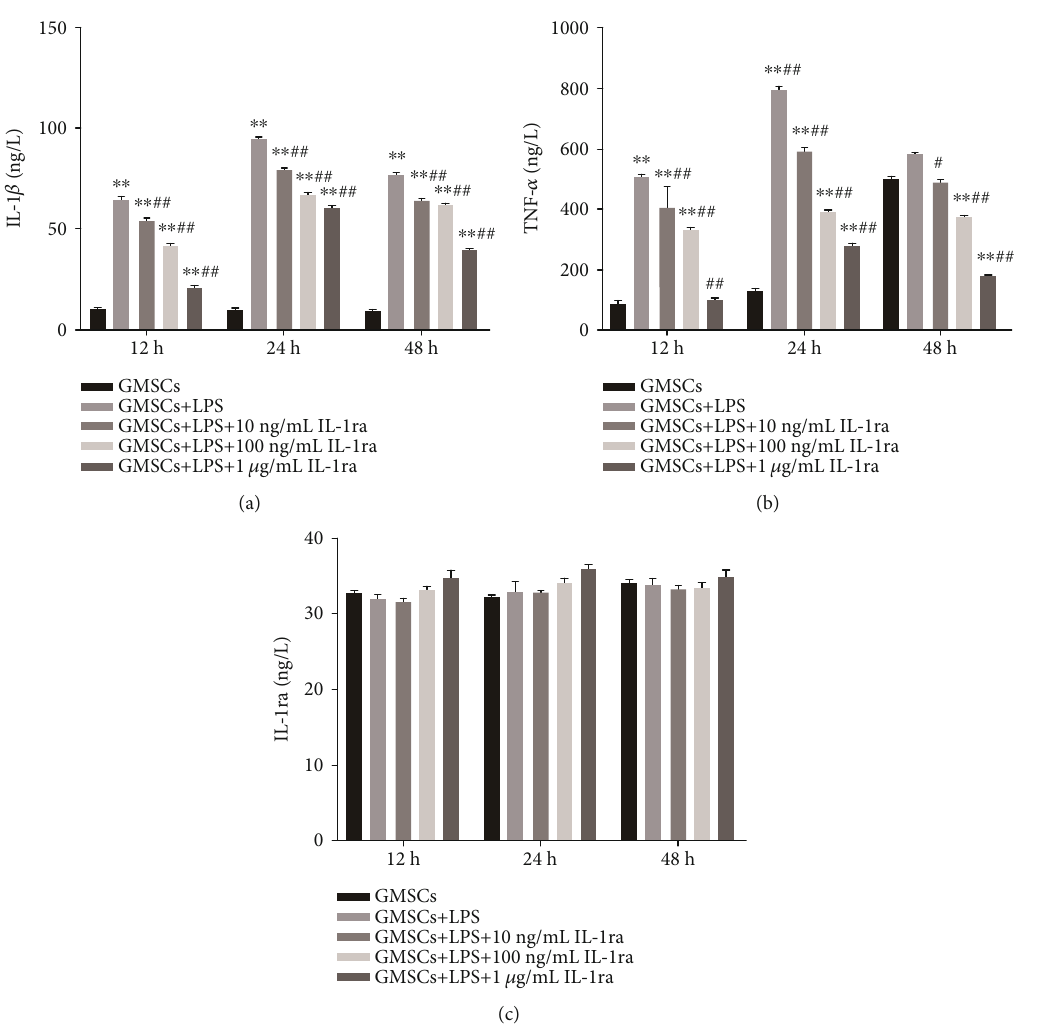
Figure 10: E ff ects of P. gingivalis -LPS and IL-1ra on cytokine release in rGMSCs after 12, 24, and 48 hours, as measured by using ELISA kits. (a) The production of IL-1 β . (b) The production of TNF- α . (c) The production of IL-1ra. ∗ P < 0 : 05 , ∗∗ P < 0 : 01 vs. GMSCs; # P < 0 : 05 , ## P < 0 : 01 vs.